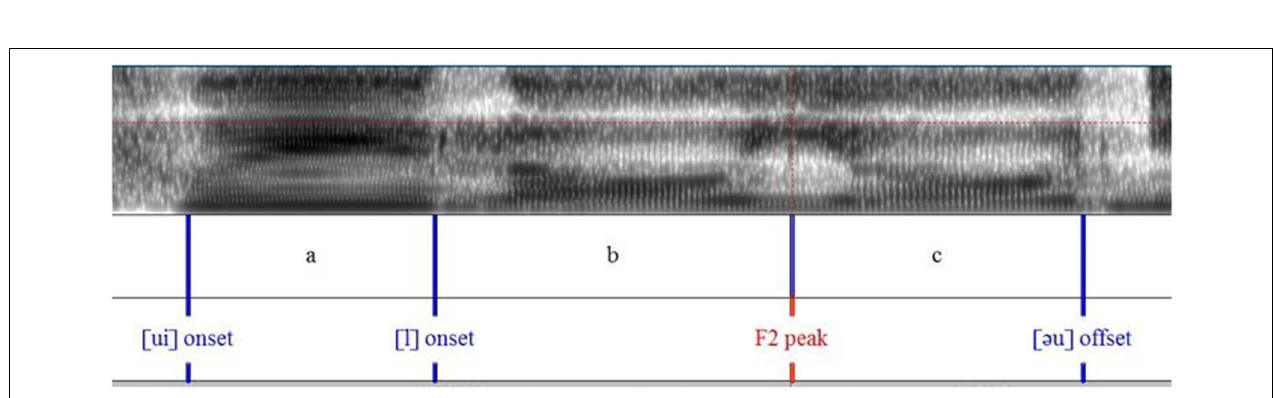
FIGURE 7 | Syllable segmentation and labeling of the sentence “ Cui louyou nian shu qu le .”